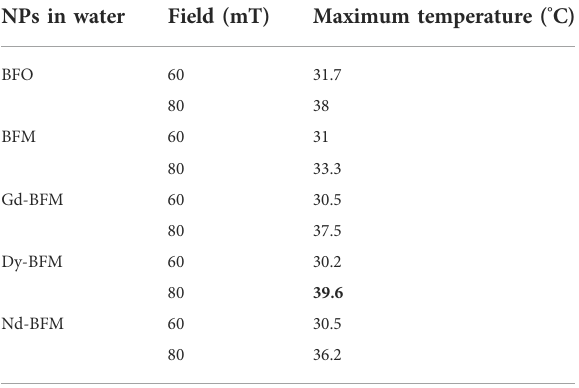
Meaning of bold value shows reaching close to hyperthermia temperature window.